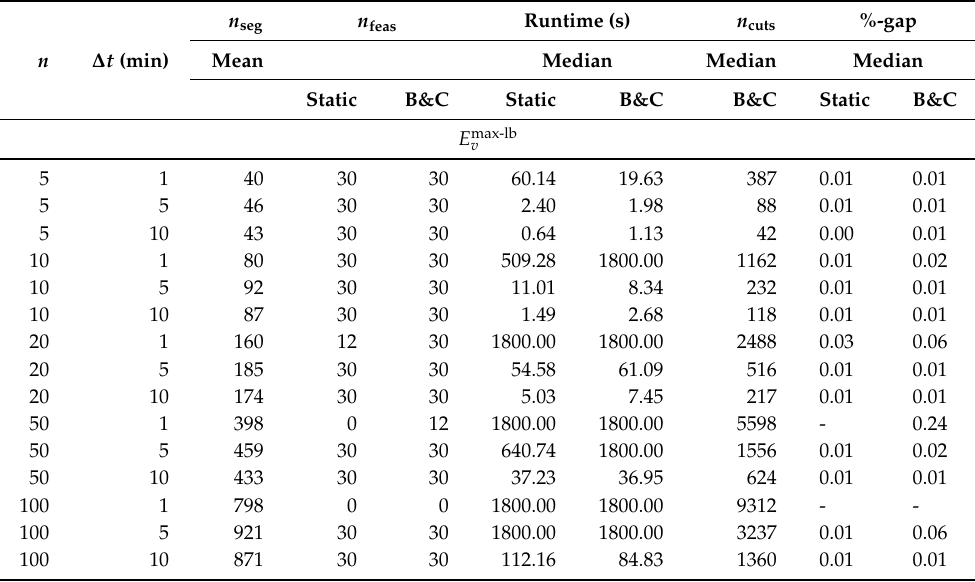
Table 6. EVS-SOC-GLIN results for solving the static model versus B&C with E max-lb v based on five-segment piecewise linear approximations of the original P max v functions, P gridmax = 25 n